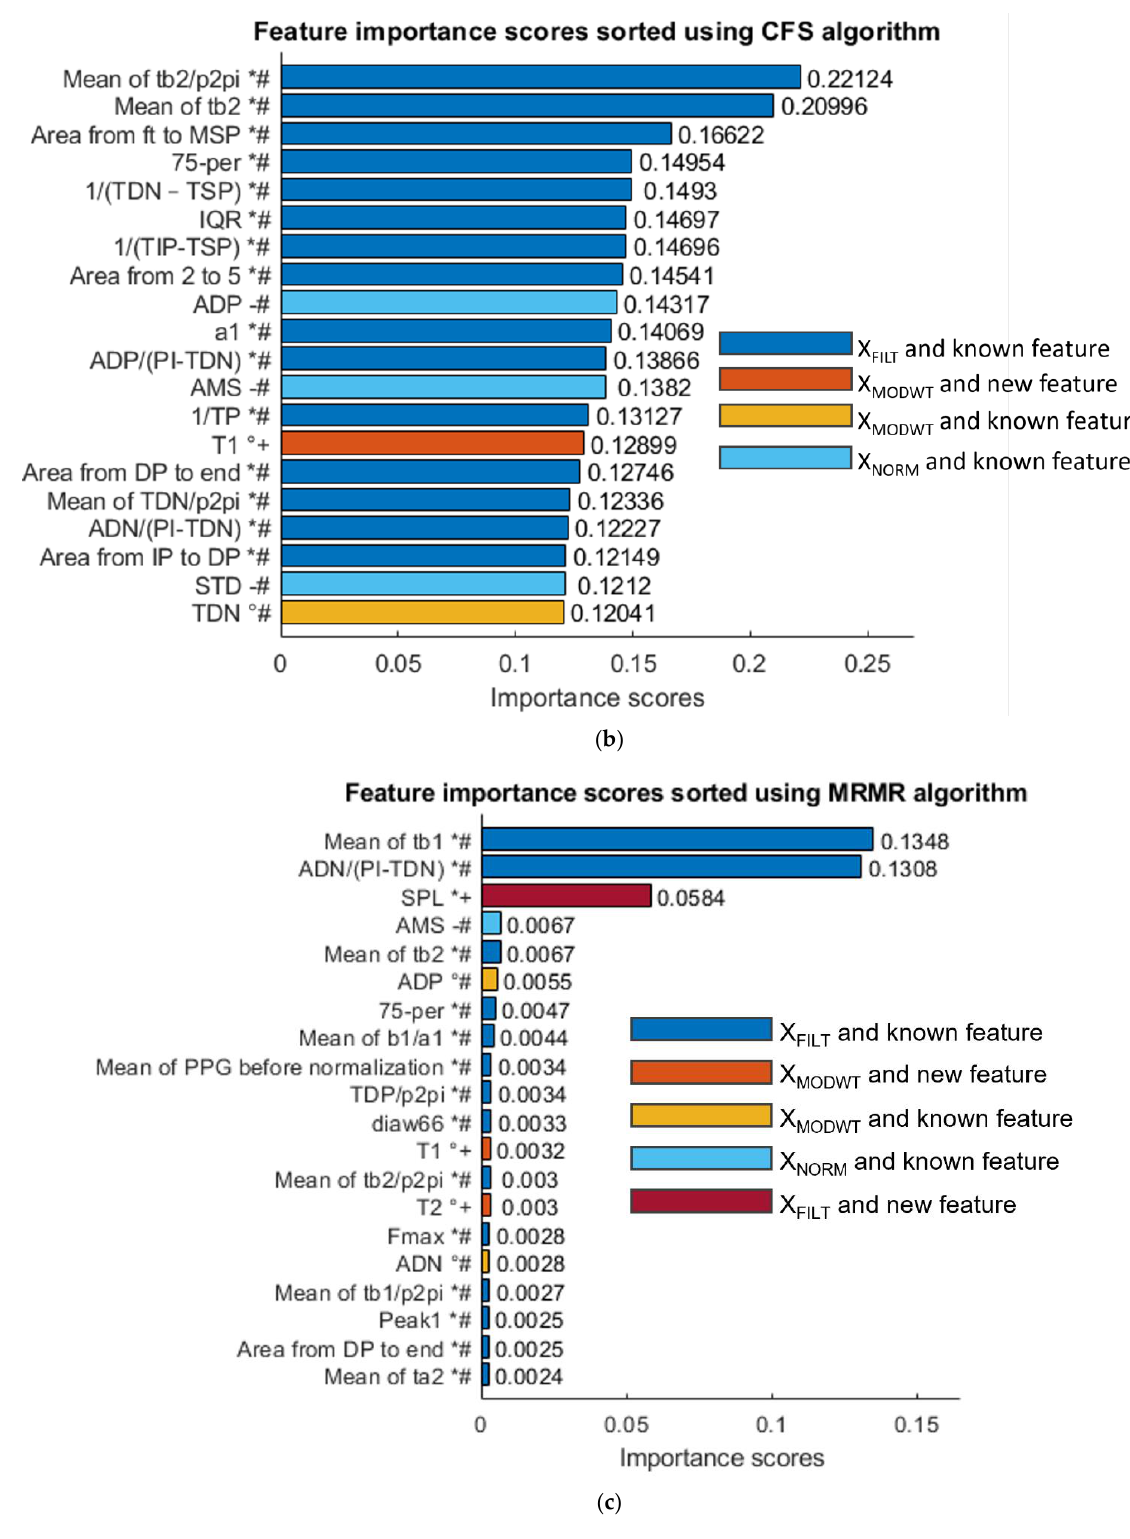
Figure 10. ( a ) Feature importance scores sorted using RReliefF algorithm for SBP measurement; ( b ) feature importance scores sorted using CFS algorithm for SBP measurement; ( c ) feature importance scores sorted using MRMR algorithm for SBP measurement. Feature labels are noted as follows: (*) calculated on x FILT (i.e., before MODWT enhancement), ( ◦ ) calculated on x MODWT (i.e., after MODWT enhancement), (-) calculated on the normalized signal x NORM , (+) new feature and (#) already known